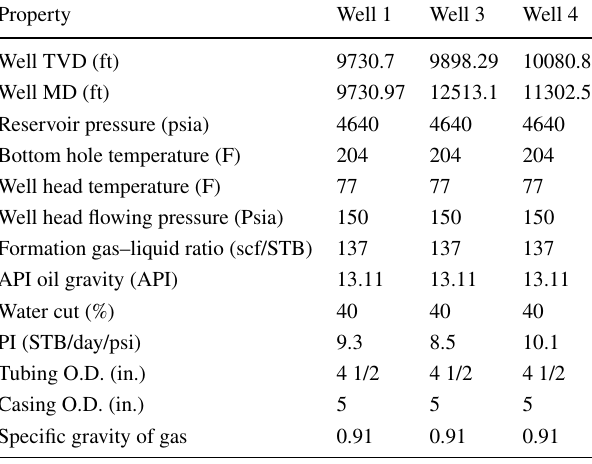
Table 8 Constants of the proposed model obtained from the